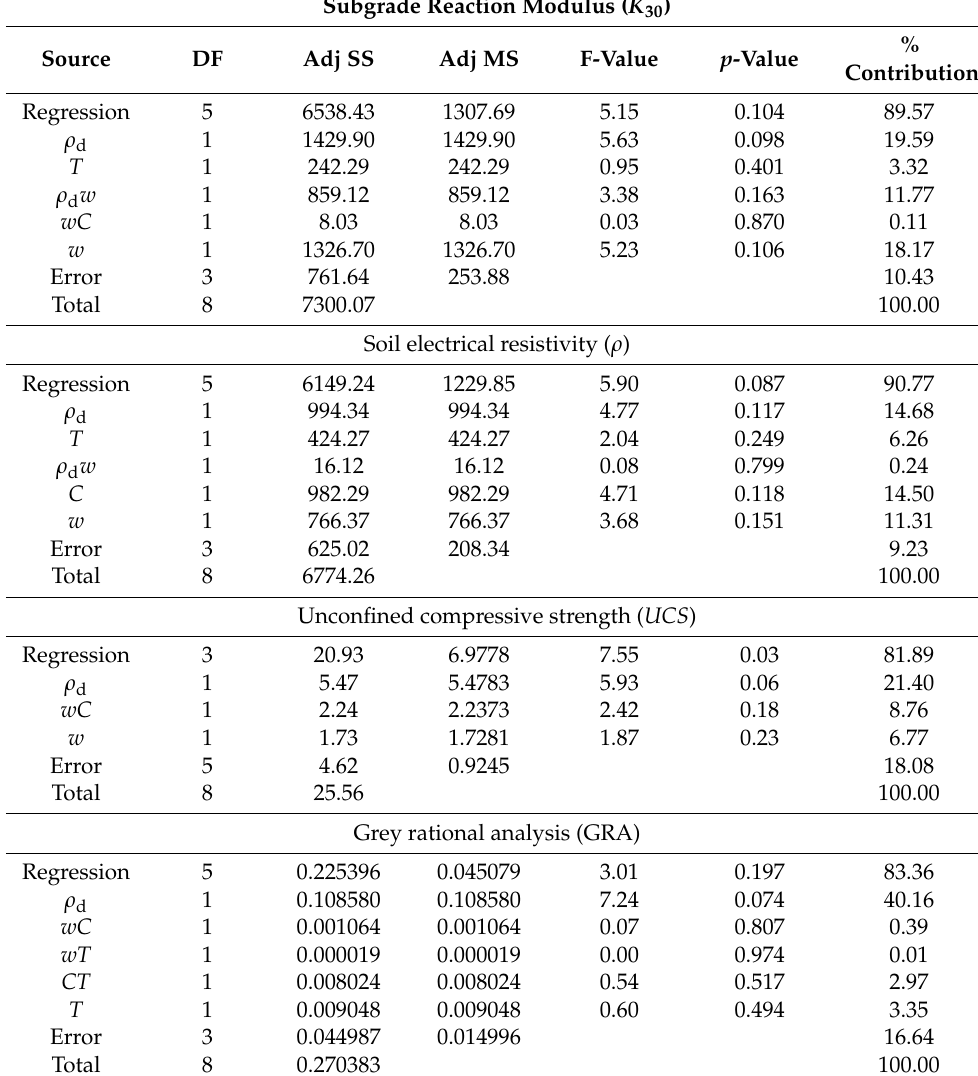
Table 6. Variance analysis of the regression